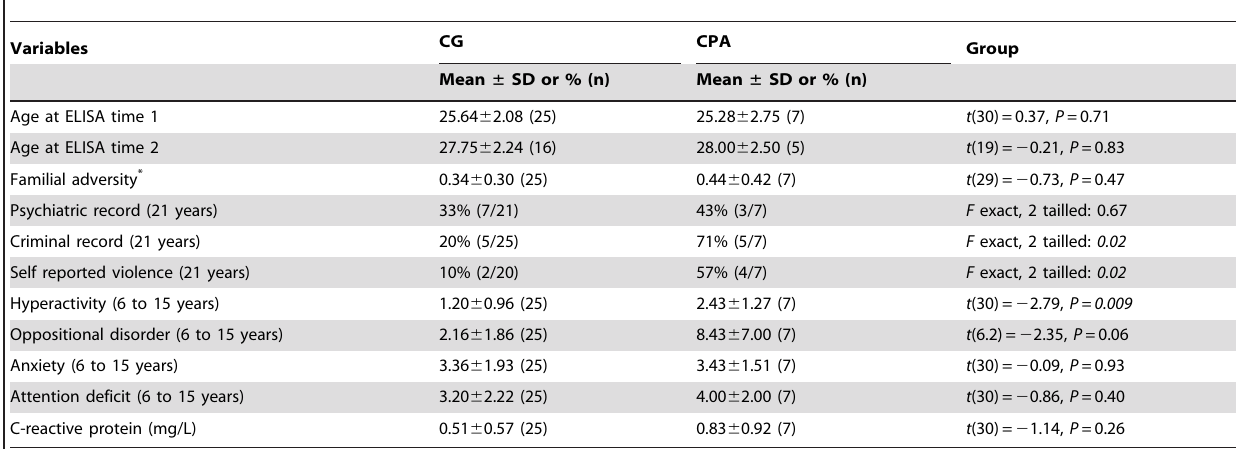
Table 1. Characteristics of the chronic physical aggression (CPA) group and control group